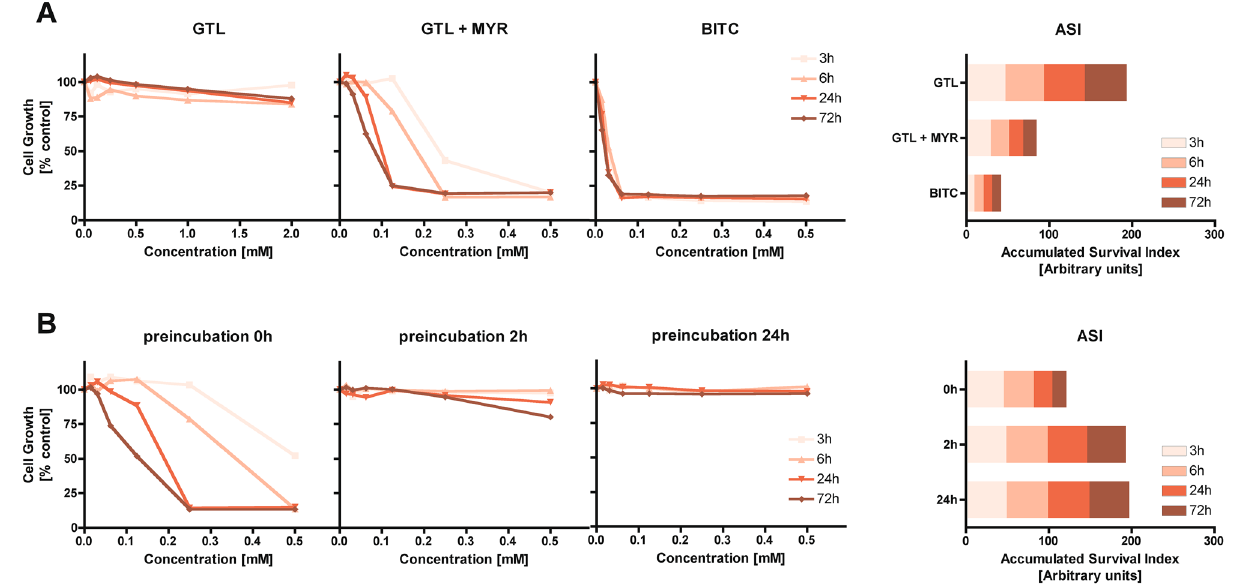
Figure 3. Growth inhibition of human adenocarcinoma cancer cells (HT29) treated with GL or its derivative directly ( A ) or after preincubation with myrosinase ( B ) evaluated by MTT test after different incubation periods (3, 6, 24, and 72 h). ( A ) Cells exposed to glucotropaeolin (GTL), glucotropaeolin, and myrosinase (GTL + MYR) or GTL hydrolysis product—benzyl isothiocyanate (BITC). ( B ) Cells exposed to the combination of GTL and MYR incubated before cell treatment for different periods (0, 2, and 24 h). Accumulated Survival Index (ASI) is defined as the sum of areas under survival curves determined for individual treatments for the same concentration range (0–0.5 mM). The results represent the means of three independent experiments; SD values did not exceed 15%.